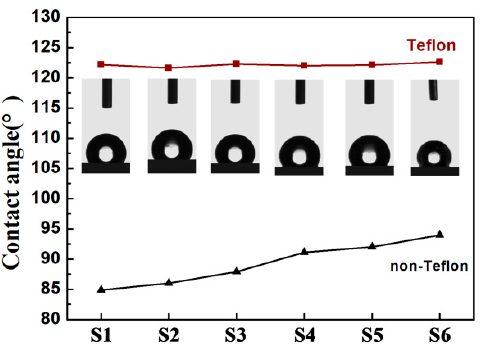
Figure 9. Static contact angle of bilayer dielectric (blended films covered with Teflon, PVT/PMMA/Teflon) and single-layer films (no Teflon covered, PVT/PMMA) in open air.